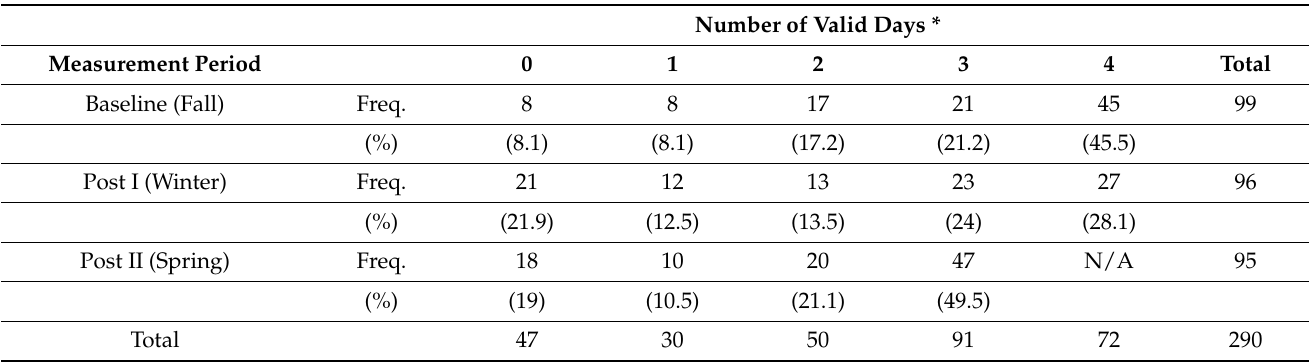
Table 1. Valid accelerometer afterschool wear